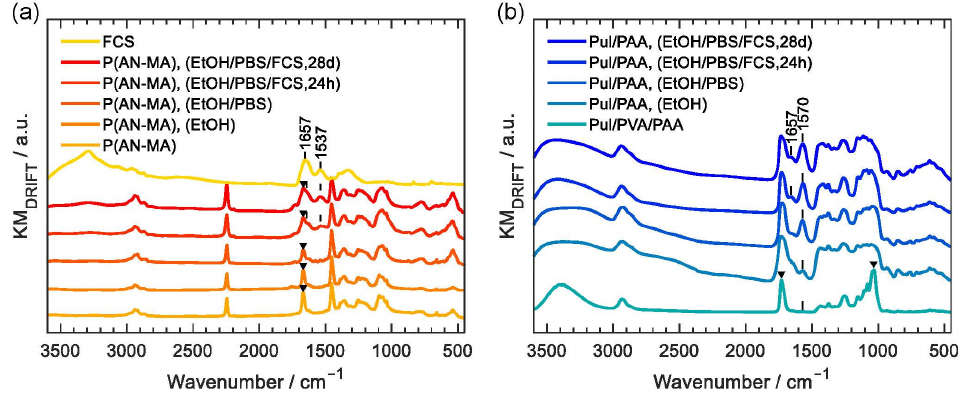
Figure 3. DRIFT infrared spectra of P(AN-MA) ( a ) and Pul/PVA/PAA ( b ) nanofiber mats at different treatment steps.